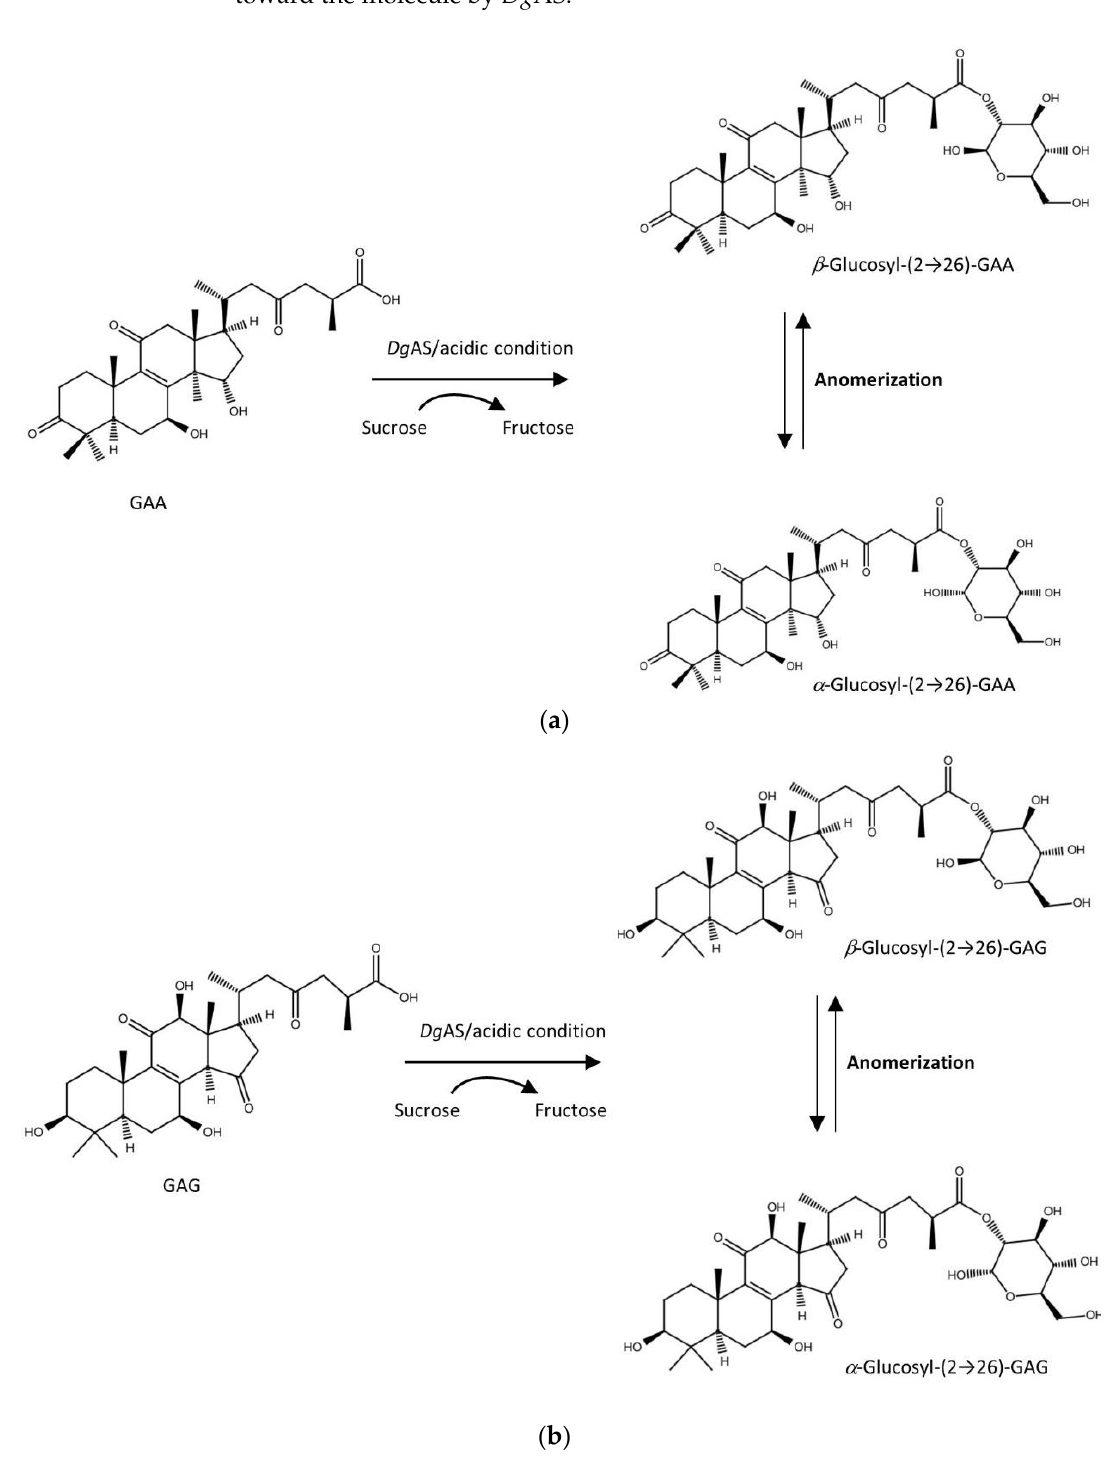
Figure 5. The biotransformation process of GAA ( a ) and GAG ( b ) to the corresponding glycosides by Dg AS.